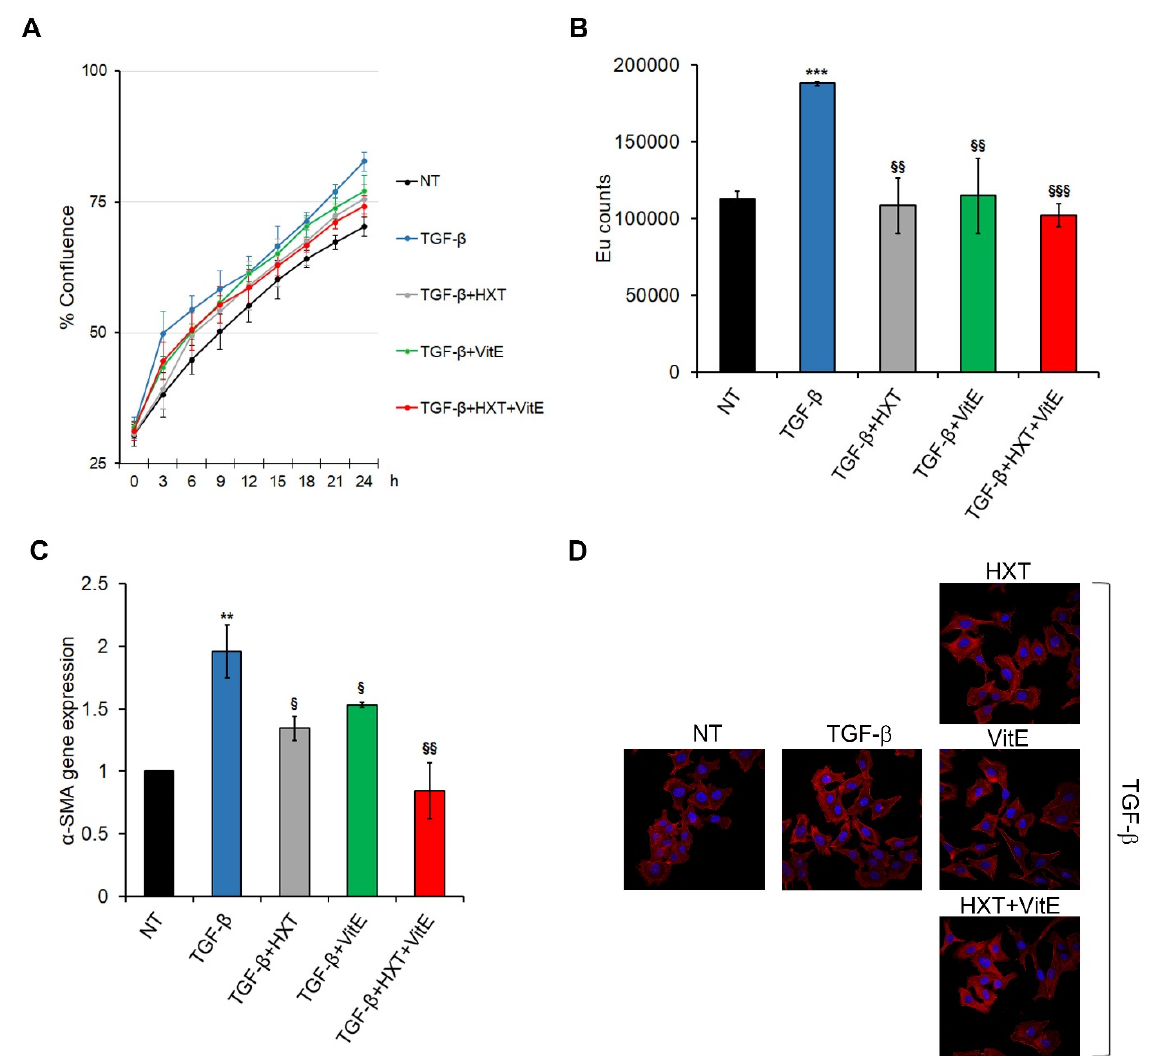
Figure 1. The combined treatment with HXT + VitE reduces the TGF- β -induced HSCs activation in LX-2 cells. ( A ) Real-time proliferation assay in LX-2 cells NT or treated with TGF- β alone or with indicated concentrations of HXT, VitE, or HXT + VitE for 24 h. Cell proliferation was reported as the percentage of confluence ± SD of two independent experiments. ( B ) Cell proliferation evaluated by a BrdU incorporation assay and expressed as Eu counts. Data are expressed as the mean ± SD of three independent experiments. *** p < 0.001 vs. NT; §§ p < 0.01; and §§§ p < 0.001 vs. TGF- β . ( C ) qRT- PCR of α -SMA in LX-2 cells NT or treated with TGF- β alone or with indicated concentrations of HXT, VitE, or HXT + VitE for 24 h. Data are expressed as the mean ± SD of three independent experiments. ** p < 0.01 vs. NT; § p < 0.05; and §§ p < 0.01 vs. TGF- β . ( D ) Representative images of phalloidin (red) cellular localization by IF in LX-2 cells NT, or treated with TGF- β alone or with indicated concentrations of HXT, VitE, or HXT + VitE for 24 h. Nuclei were stained by Hoechst (blue). Magnification 40×. 3.2. The Combination Treatment with HXT and VitE Inhibits TGF- β -Induced HSC Migration, Contractility and Pro-Fibrogenic Phenotype In their activated phenotype, the upregulation of α -SMA expression in HSCs is accompanied by the acquisition of migratory and contractility properties with a consequential shift into a myofibroblast-like phenotype [22]. Here, we evaluated the effect of HXT + VitE on these pro-fibrogenic events that occurred in TGF- β -activated LX-2 cells.